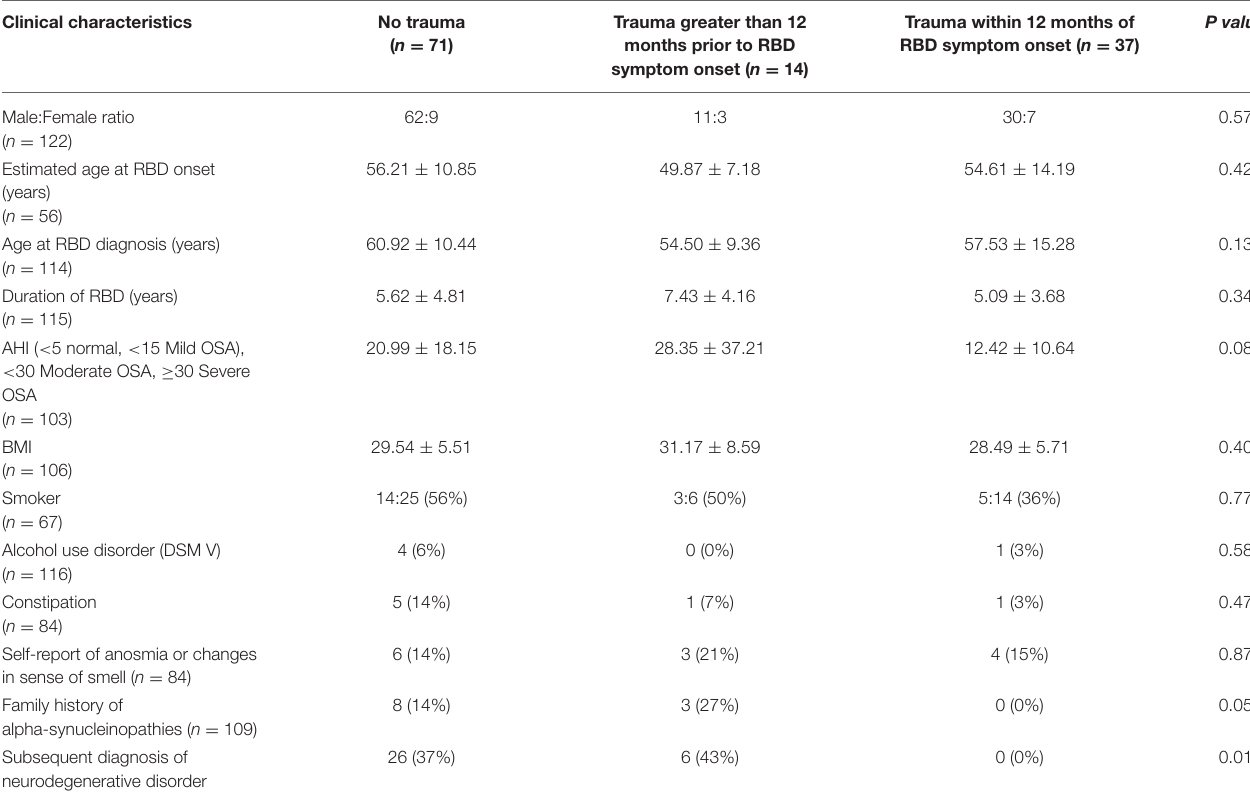
TABLE 2 | Differences in clinical characteristics across groups diagnosed with iRBD. Clinical